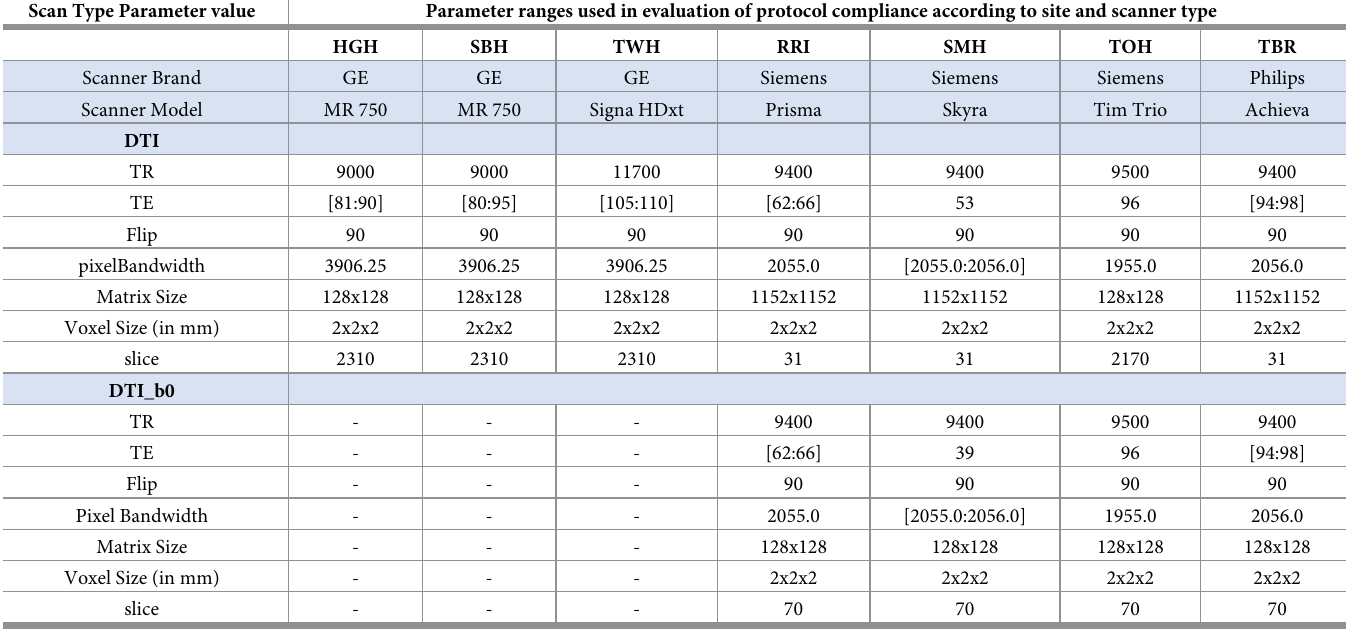
Table 1. DTI data acquisition parameters for the different MRI scanners utilized in the current study. Scan Type Parameter value Parameter ranges used in evaluation of protocol compliance according to site and scanner